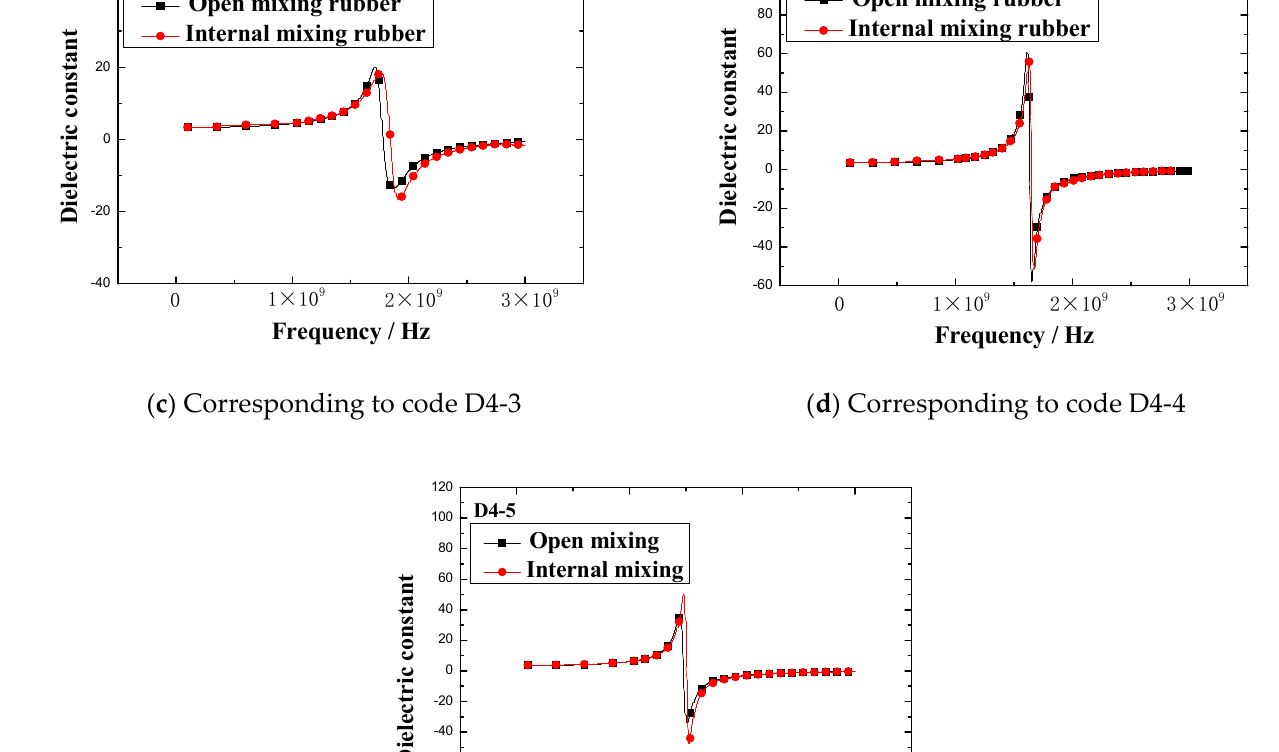
stant gradually increased with the frequency, when the frequency increased to a certain